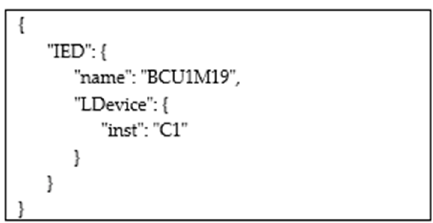
Figure 7. Example of the JSON frame containing the data type description of the LD belonging to the IED “BCU1M19”.